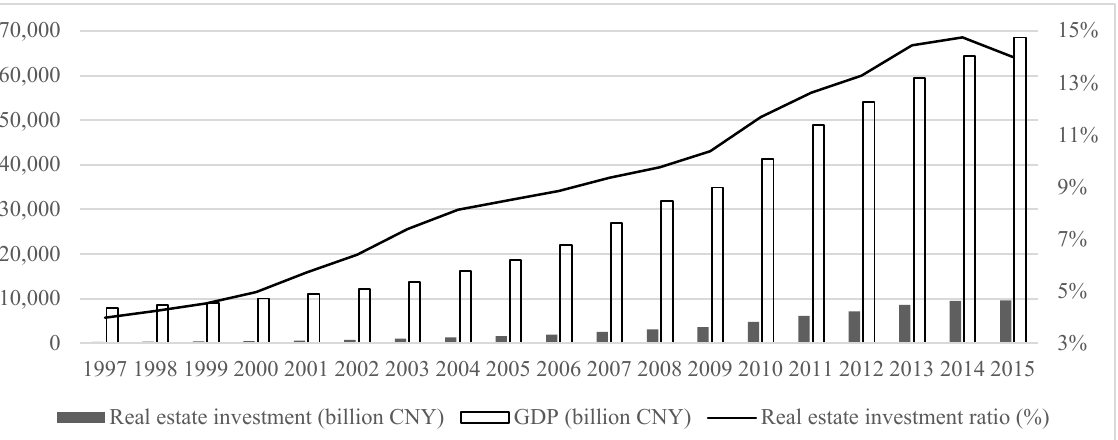
Figure 1. Ratio of real estate investment to GDP (1997–2015). Data source: China Statistical Year- book.